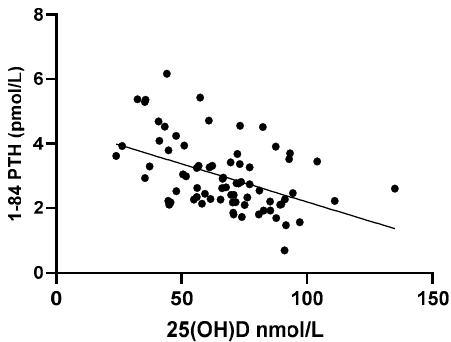
Figure 1. Linear regression analyses between vitamin D (25(OH)D) and parathyroid hormone (1–84 PTH) levels.